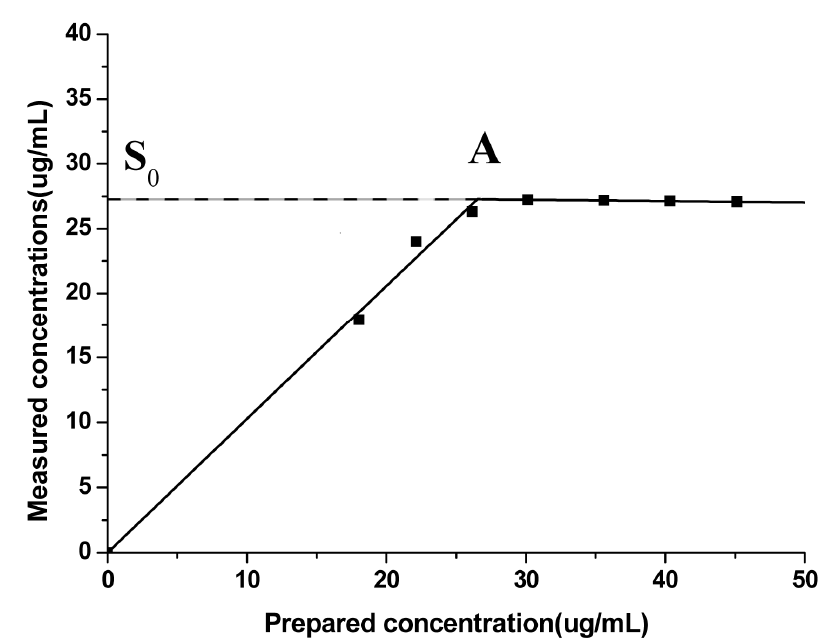
Figure 1. The determination curve of capsaicin equilibrium solubility. Abbreviations: S , equilibrium solubility; A , the intersection of two lines. 0